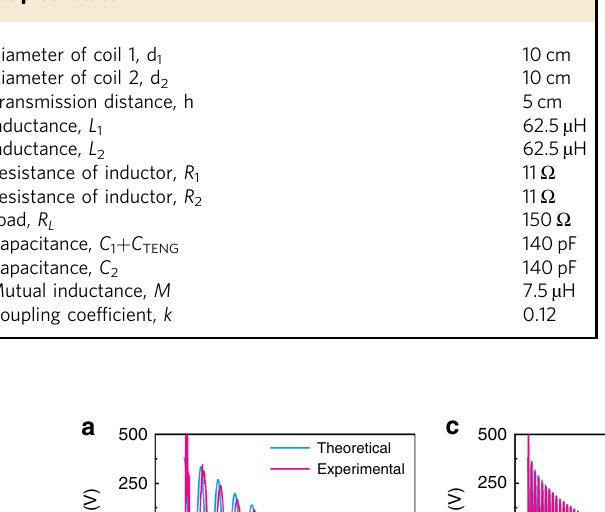
Table 1 Parameters of MR-WTENG system at the resonant- coupled